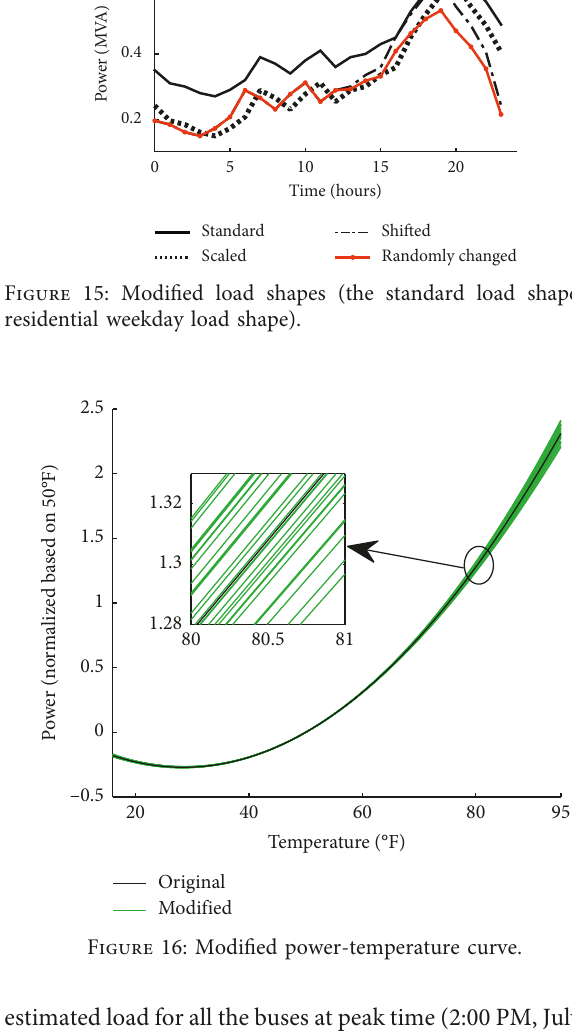
Figure 14: Estimation errors obtained by σ (dash-dot), σ ″ (solid), and σ ′ (dash): (a) absolute estimation error; (b) relative estimation error. Figure 3: network reduction, load forecasting, and state estimation, to obtain the experimental results.